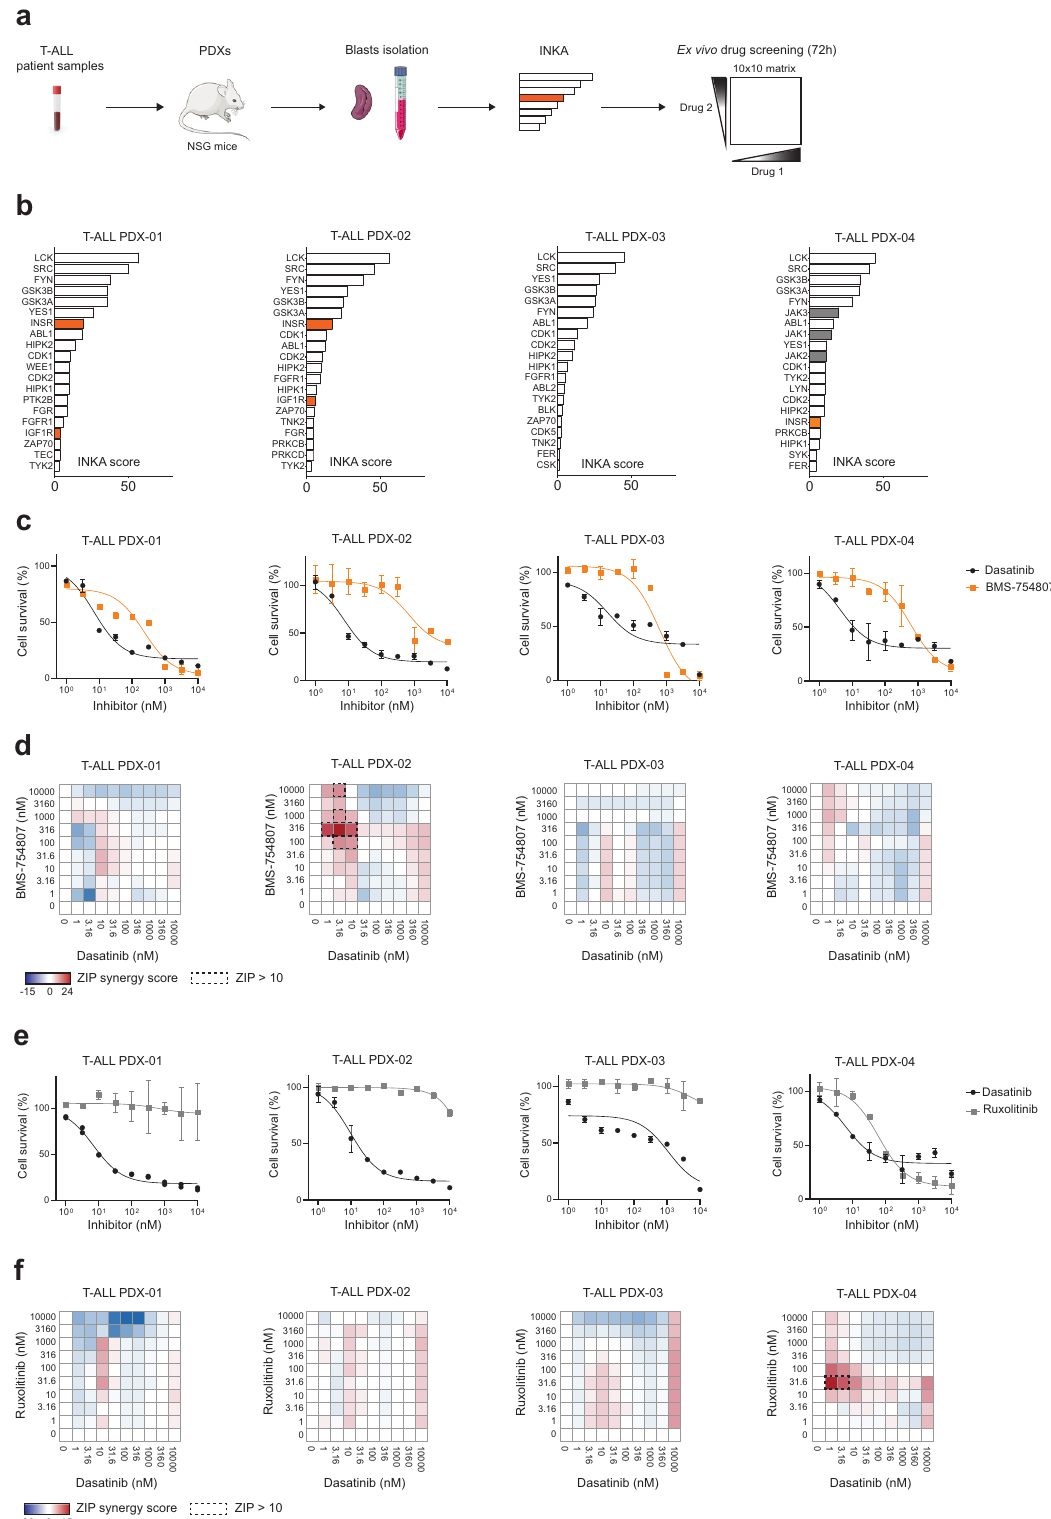
treatment (Fig. 6d). For PDX-04, INKA analysis predicted only INSR activity with a low ranking (16/20; Fig. 6b) indicating that INSR is not one of the dominant activities and thus explaining the lack of synergy upon combination treatment. Nevertheless, PDX- 04 presented high Janus kinases (JAKs) activity which was absent in the other PDXs (Fig. 6b). Interestingly, the high JAK3 activity